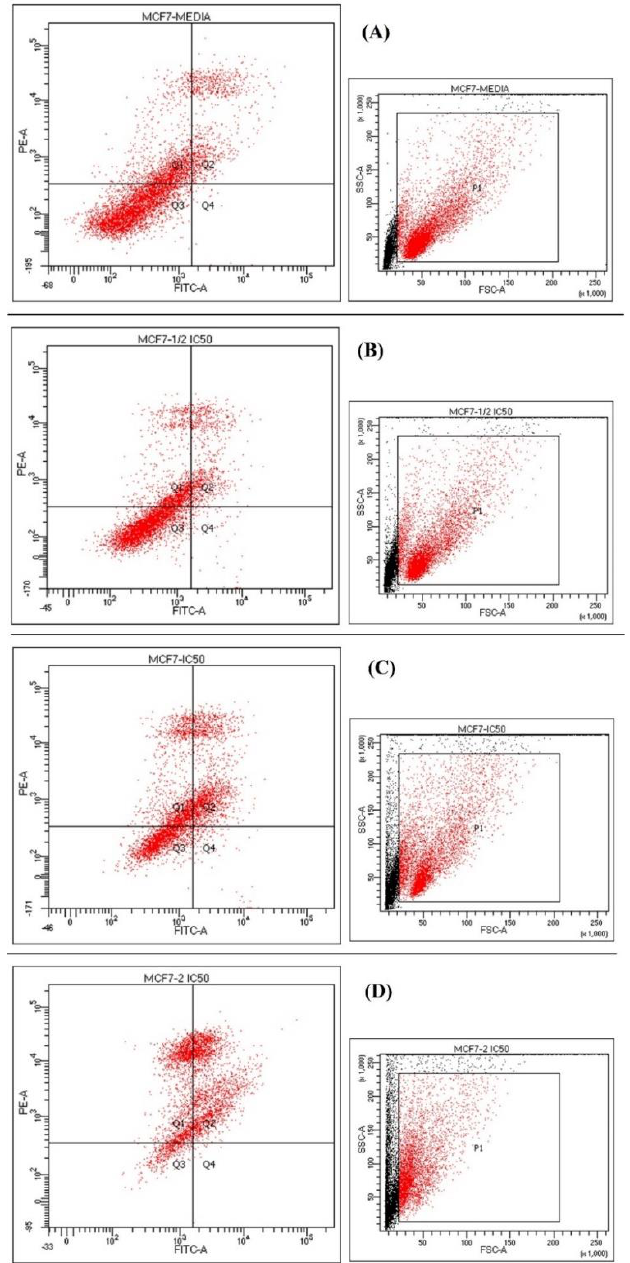
cells decreased, for both the IC 50 and double IC 50 , at 36.2% and 9.5% for the L. shawii . However, half IC 50 did not show any significant changes. The necrotic cells percentage Table 5. Annexin V-staining FACS analysis of the hydroalcoholic extract of L. shawii. for L. shawii increased to 28.1% and 36.5% for the IC 50 and 2 × IC 50 as compared to the 22.9% of the untreated group (Table 5). In addition, using the concentrations equal to IC 50 and 2 × IC 50 for L. shawii extract, the late apoptotic cells viability increased to 33.4% and 53.6%, respectively. These results demonstrated that the L. shawii cytotoxic effects were dose-dependent, as, once the concentration was increased from IC 50 to double IC 50 , the percentage of the necrosis increased in a directly proportional relationship. These data also MCF-7, effectively.